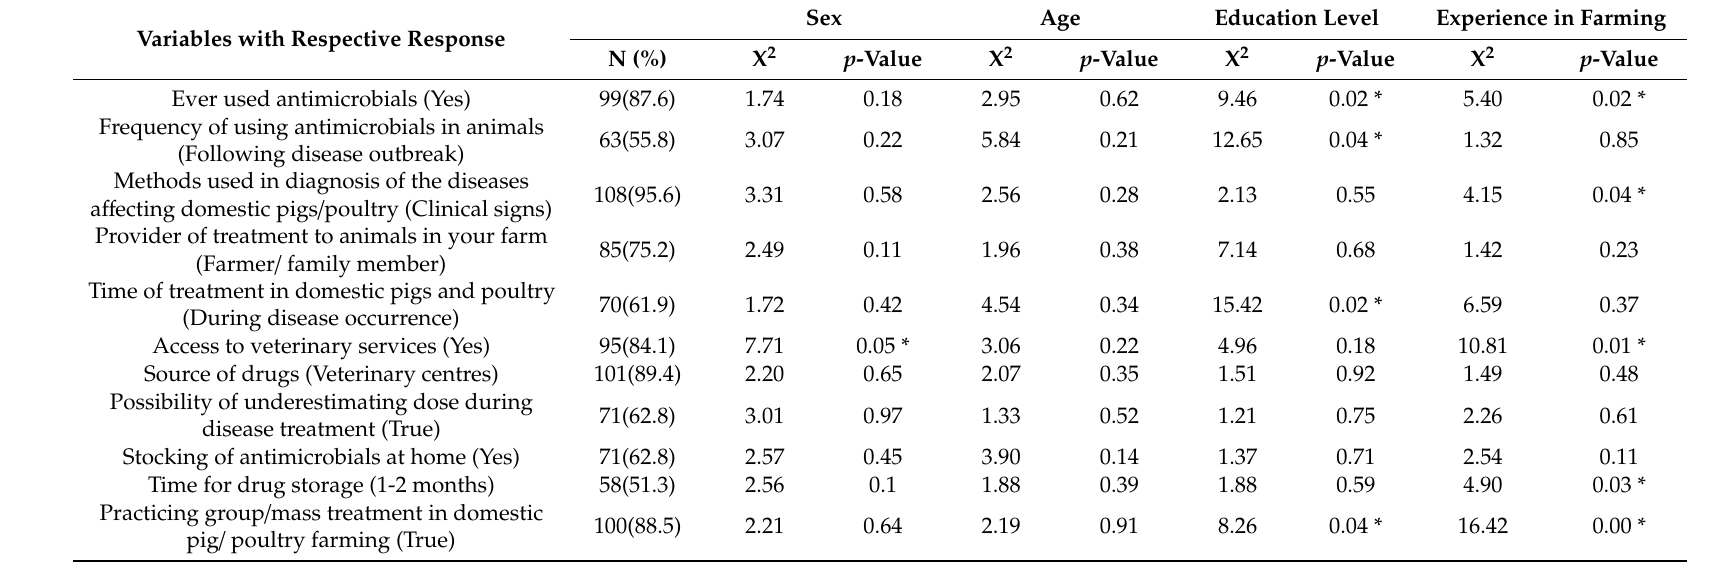
Table 3. Number and percentage of respondent’s response to the practice related to antimicrobial use. Variables with Respective